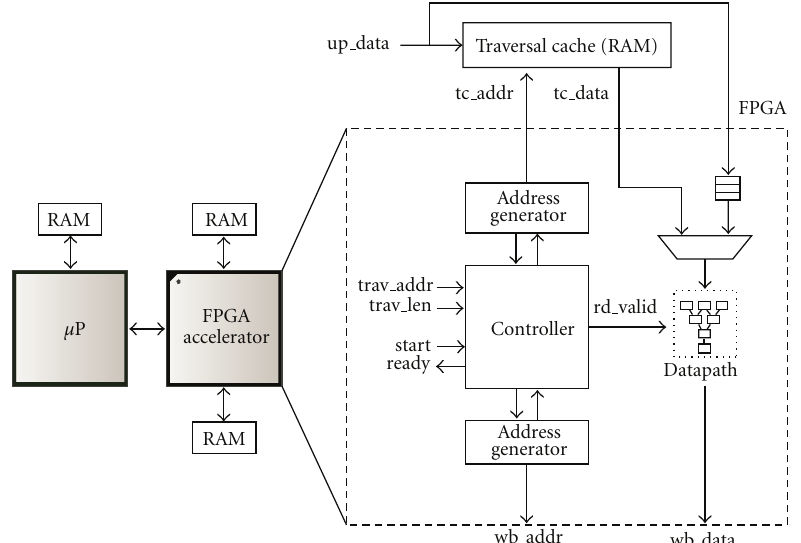
Figure 2: System architecture of the generalized traversal cache framework. On the first of a repeated traversal of a pointer-based data structure, software sends the elements to the FPGA on up data , which is simultaneously written to the cache memory and consumed by the accelerator datapath. On subsequent traversals, the accelerator reuses the sequence of data in the cache, which can be read sequentially using simple constant stride address